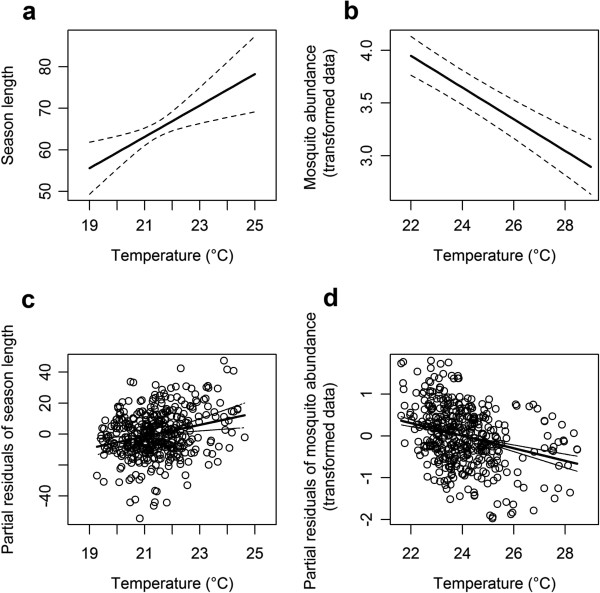
Association between season length, total abundance and late season temperatures. Panels a-b show model predictions; panels c-d show partial residuals. The first column (a,c) shows the association between late season temperature (LST16–27) and season length; the second column (b,d) shows the association between late season temperature (LST21–32) and mosquito abundance. Note that plots in the second column show transformed data on the y axis (i.e. x0.2); back transformed values are presented in the text to assist interpretation.